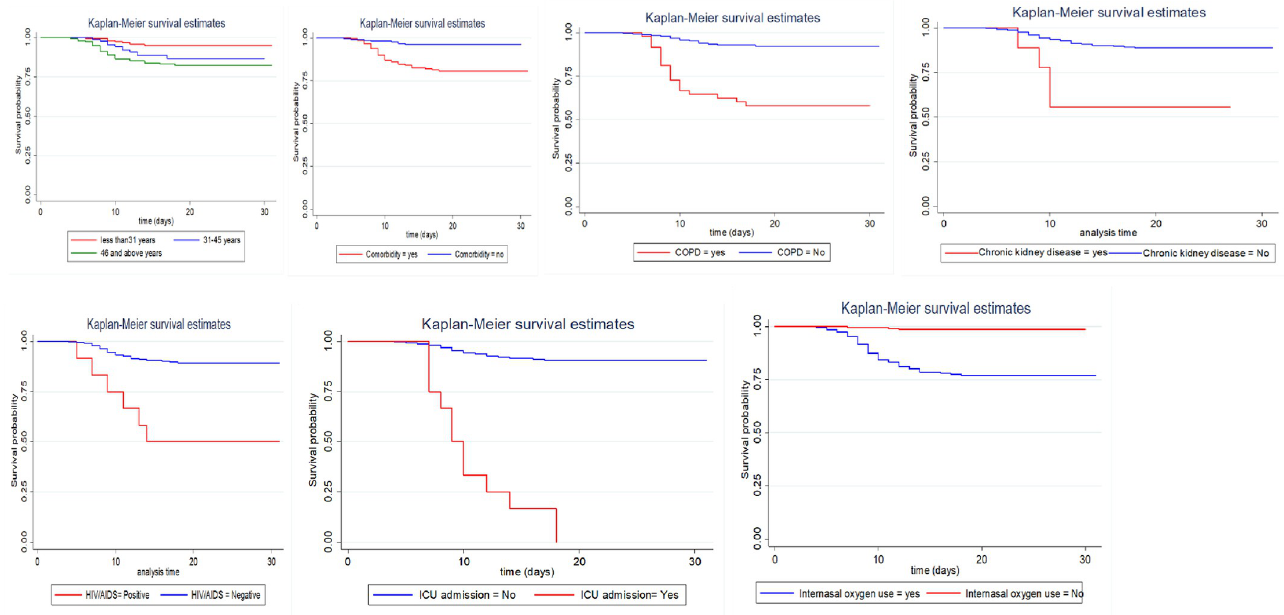
Fig 1. Survival curve of COVID-19 patients hospitalized at Bokoji Hospital treatment centre by sociodemographic and clinical characteristics, 2021.